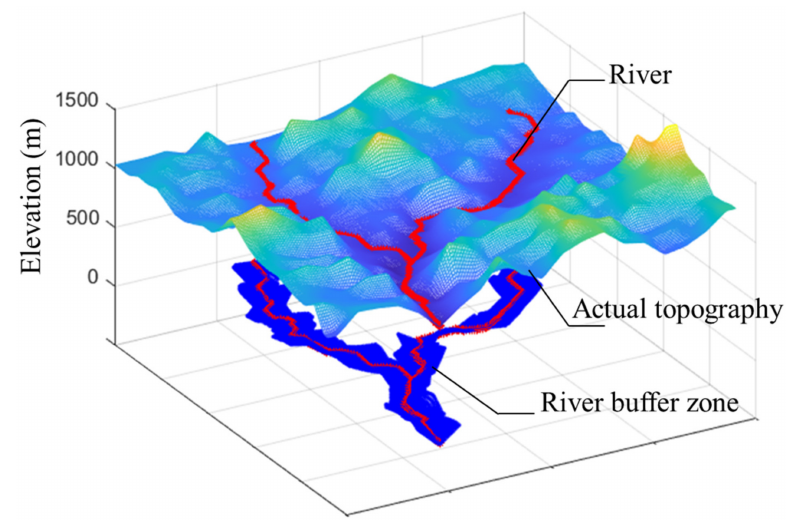
Figure 3. Schematic diagram of river buffer